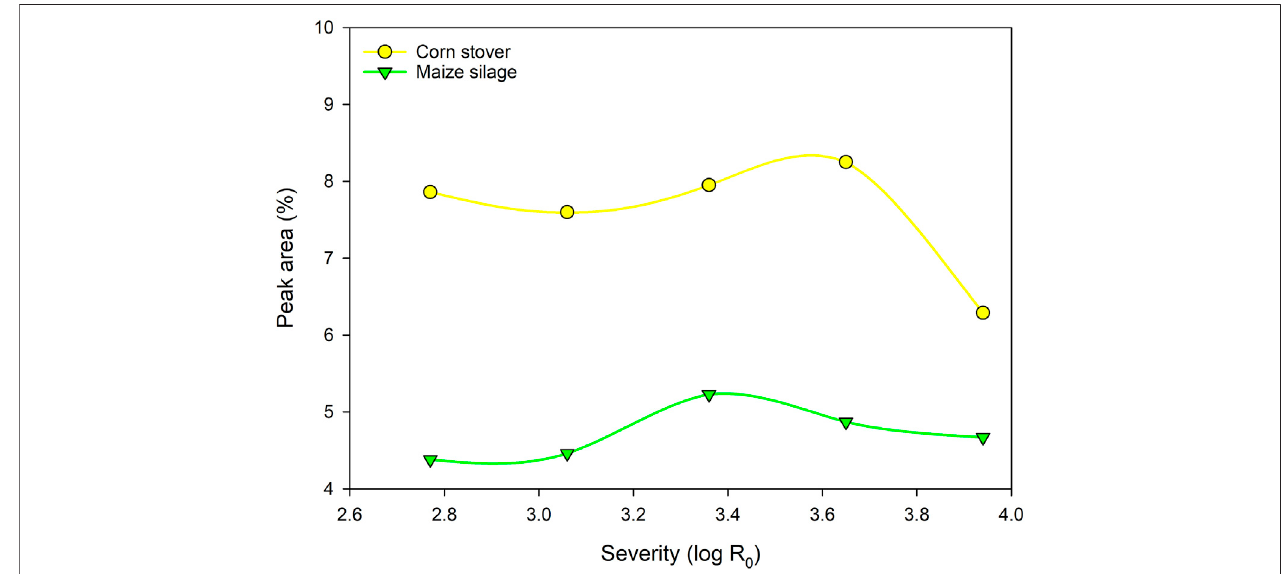
FIGURE 6 | Summarized peak area % of the main phenolic compounds detected by GC/MS for CS and MS fi ltrates. The peak area is calculated as percentage based on the area of the whole chromatogram.